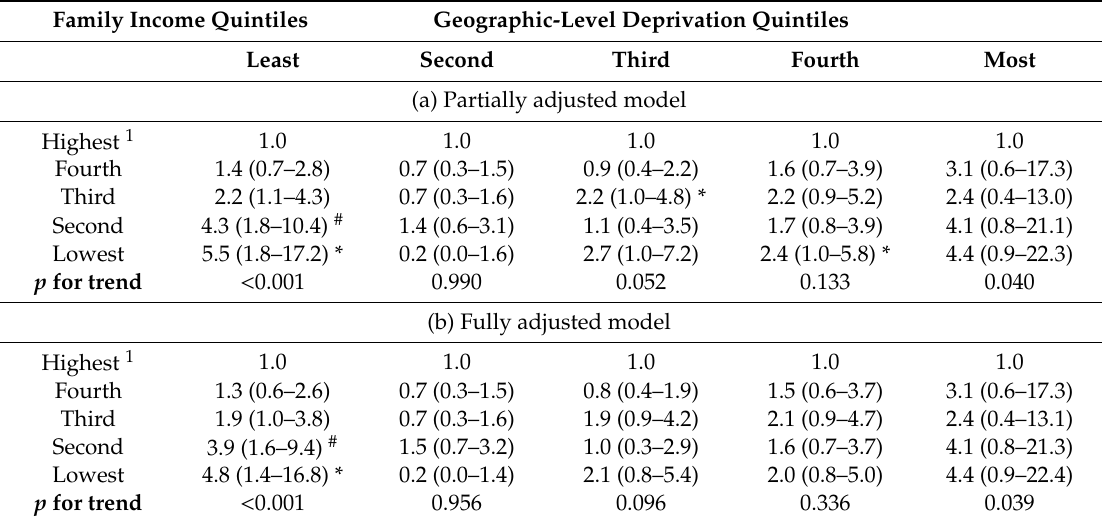
Table 4. Family income gradient in the risk of obesity, RR (95% CI), by geographic-level deprivation quintiles.